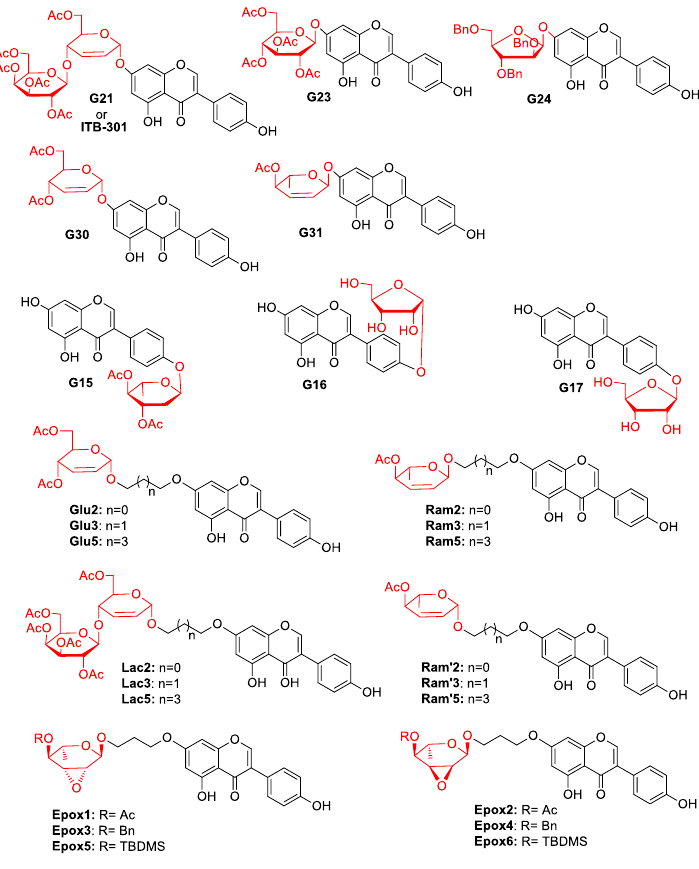
Figure 13. Genistein glycoconjugates. Conjugates of genistein and unsaturated pyranosides, in which the sugar was